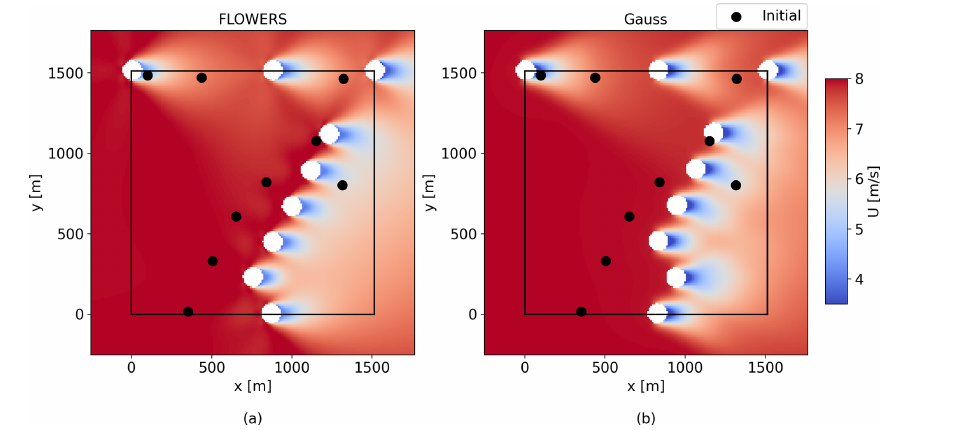
Figure 12. The optimal layouts for the FLOWERS and Gauss optimizers (with B = 360 wind direction bins). The FLOWERS solution required 50.2s and achieved an AEP gain of 7.3%. The Gauss solution required 10800s and achieved 7.4% AEP gain. The black dots denote the initial